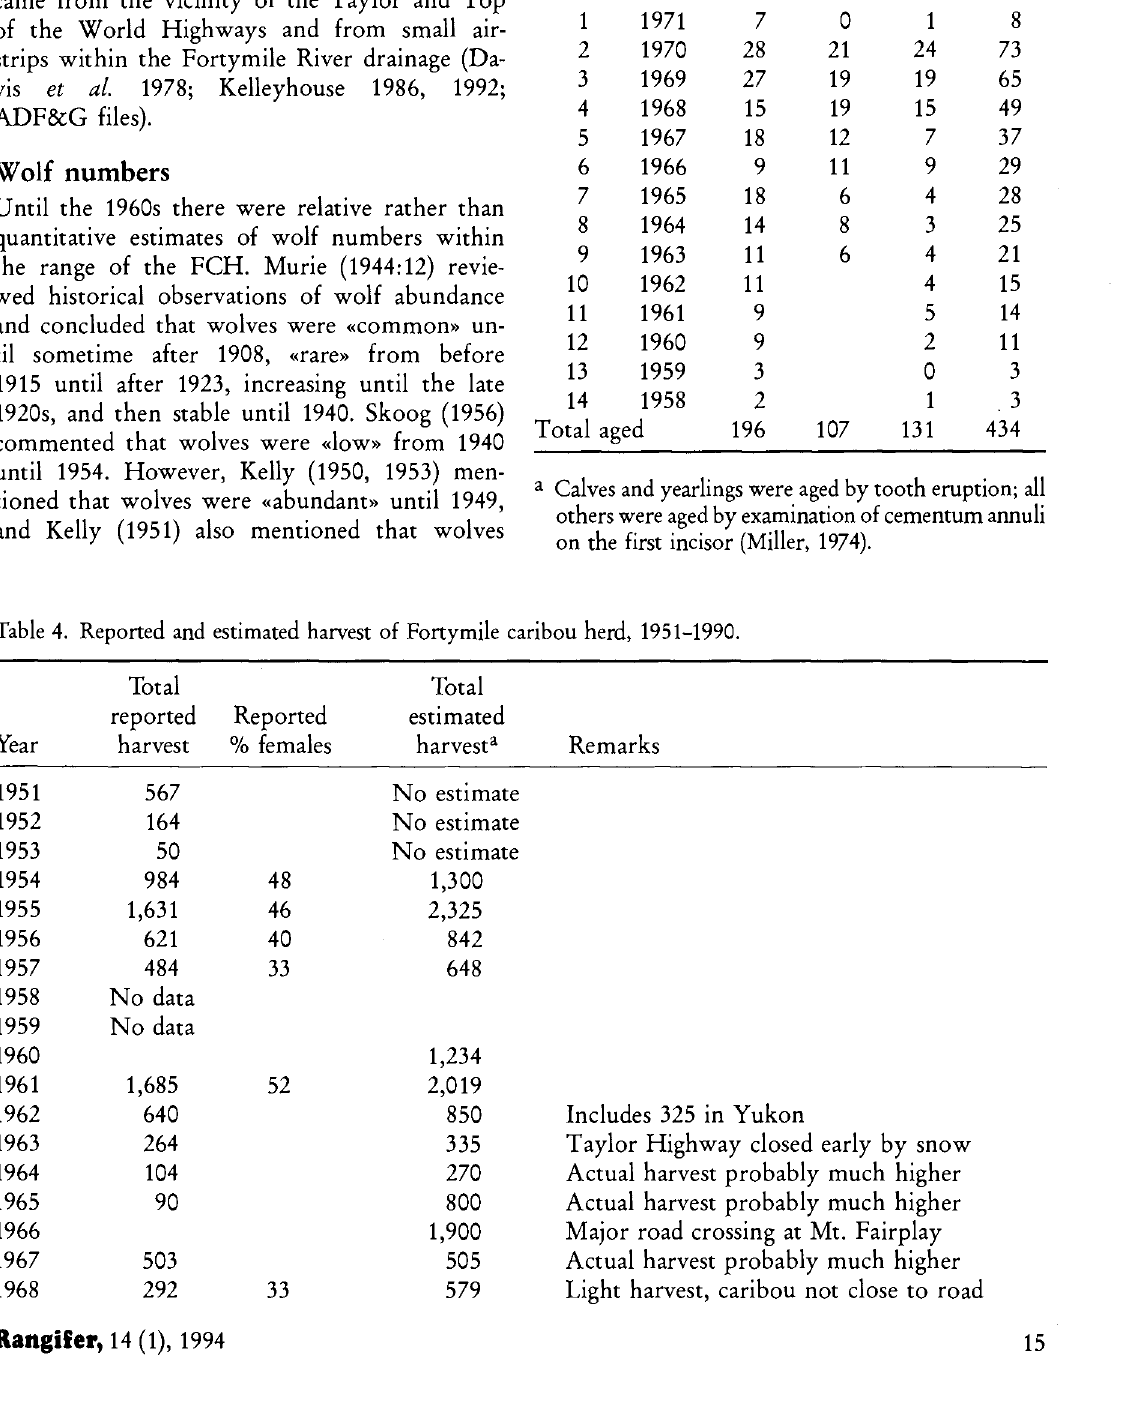
Table 4. Reported and estimated harvest of Fortymile caribou herd,